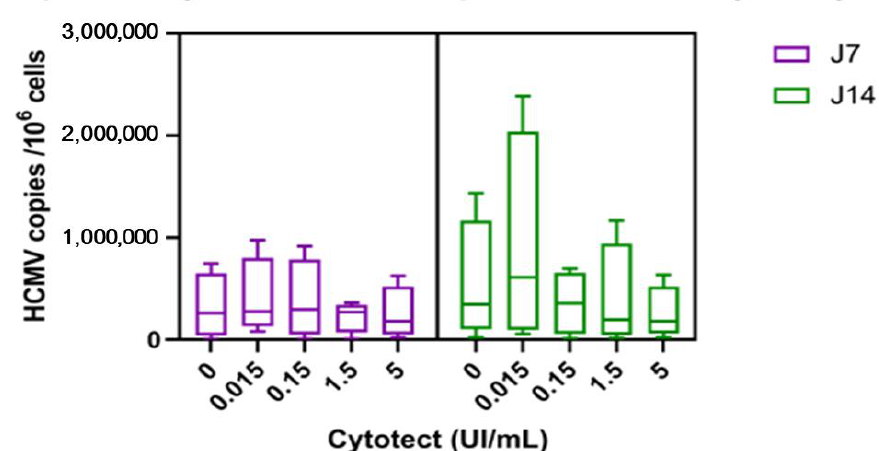
Figure 6. Efficacy assays. Viral loads were measured at 7 and 14 days post-treatment of infected villi and compared with infected and non-treated villi (positive control “0”). The results were compiled from three separate placentae. The boxplots are designed as medians (Q2), lower quartiles (Q1), and upper quartiles (Q3). The whiskers are extended to the extreme data points.